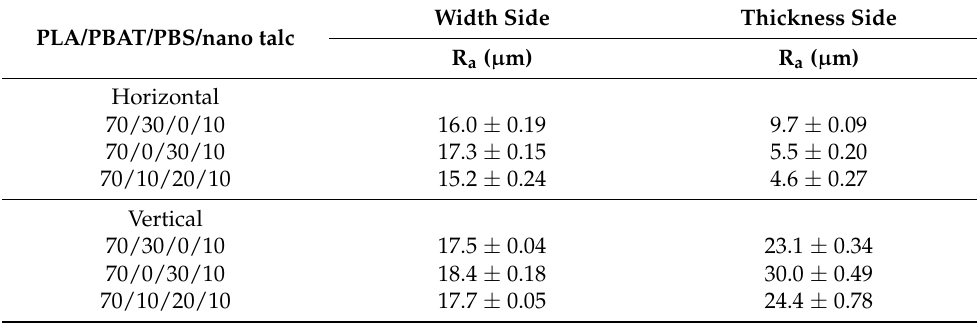
Table 8. Surface roughness average (R a ) of PLA/PBAT/PBS/nano talc composites 3D prints. PLA/PBAT/PBS/nano